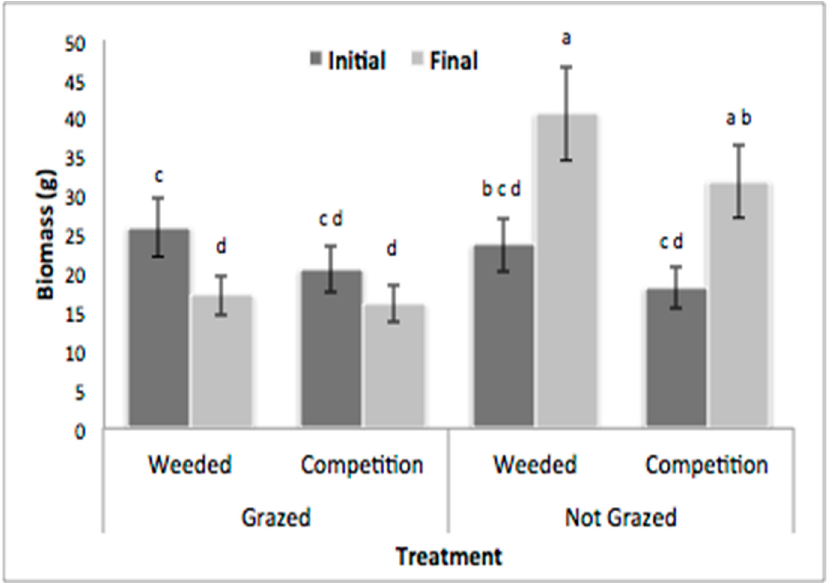
Figure 1. Mean initial and final H. bonariensis biomass (grams) for each treatment combination, with (+/ − ) standard error bars. Where letters above bars differ, this indicates statistically significant differences (Least Squares Means results, alpha = 0.05).